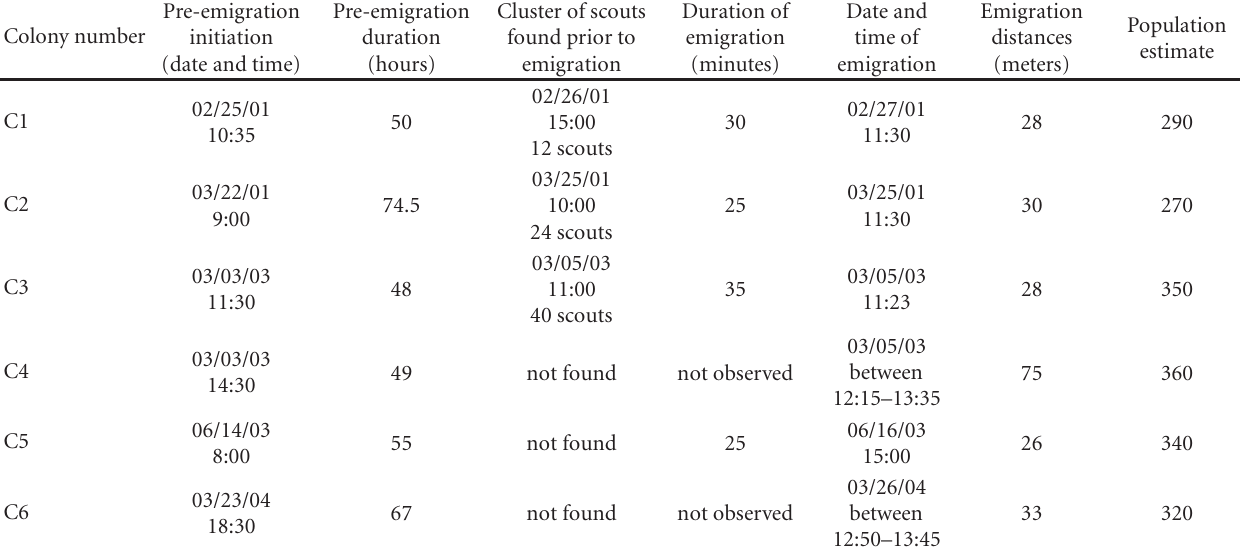
Table 1: Data relating to emigration events for the six colonies of Parachartergus fraternus studied in Brazil. See text for additional details. Pre-emigration Colony number